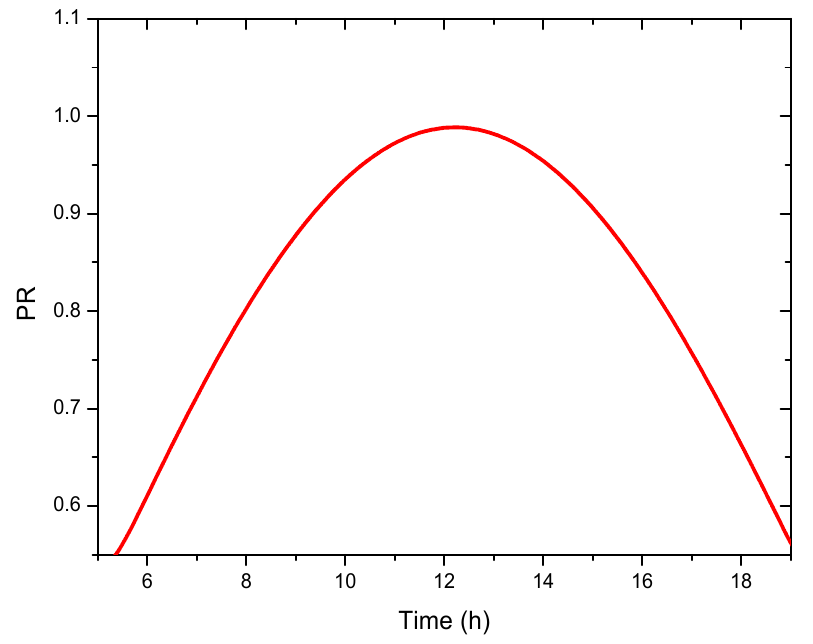
MED (Q SPE = 6 kWh.m − 3 ) and MED-TVC ( Q SPE = 5.3 kWh.m − 3 ). Therefore, Standard Primary Energy Consumption allows the efficient comparison of all desalination processes.